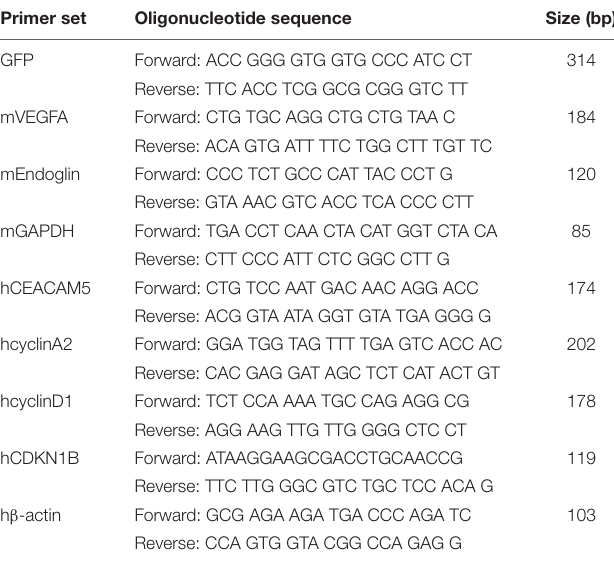
TABLE 1 | Oligonucleotide primers used for RT-qPCR